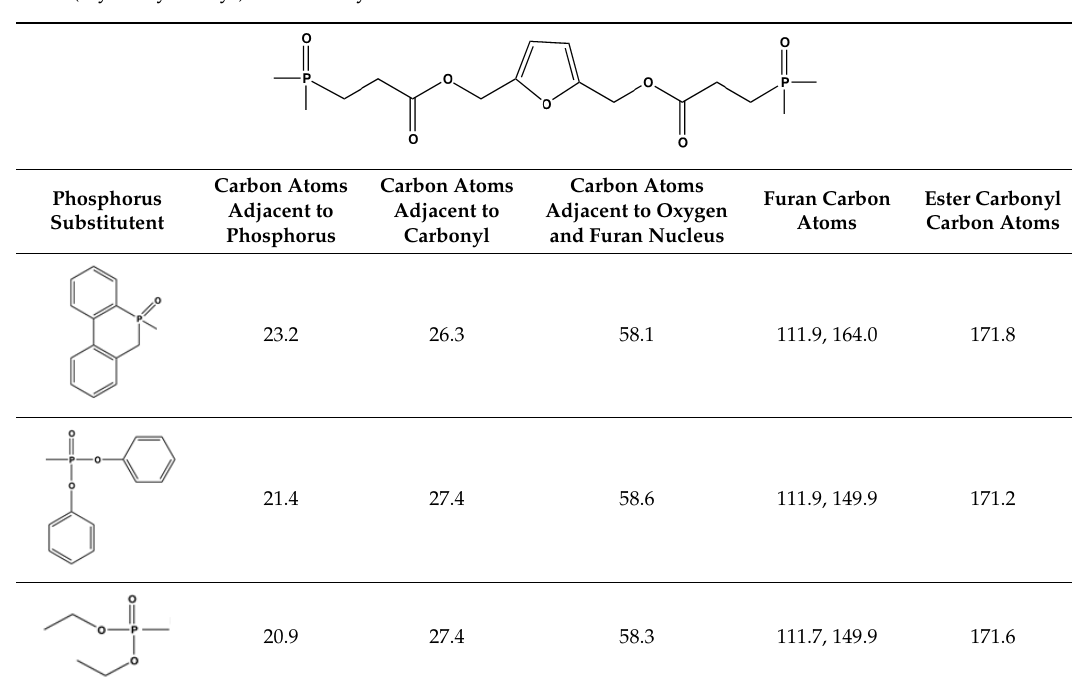
a In δ units respect the resonance of tetramethylsilane as internal reference. For comparison the corresponding DOPO derivatives of bisphenol A and tetrabromobisphenol A were prepared. Structures are shown in Figure 1. Table 3. Characteristic 13 C-NMR chemical shifts for phosphorus derivatives of 2,5- bis (Hydroxymethyl)furan diacrylate. a